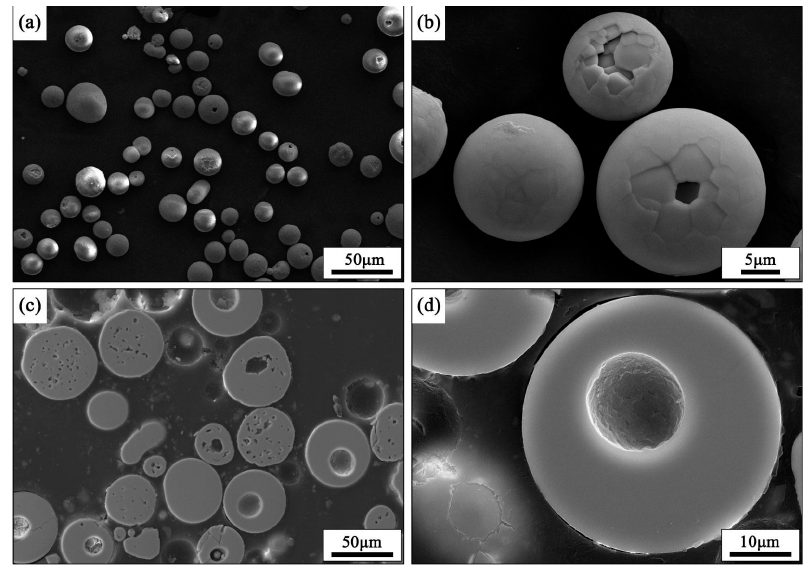
Figure 4. Surface and cross-sectional SEM micrographs of the collected YSZ particles (referred as C-AS) particles: ( a ) overall surface morphology; ( b ) surface morphology under high magnification; ( c ) overall cross-sectional morphology; and ( d ) cross-sectional morphology under high magnification.